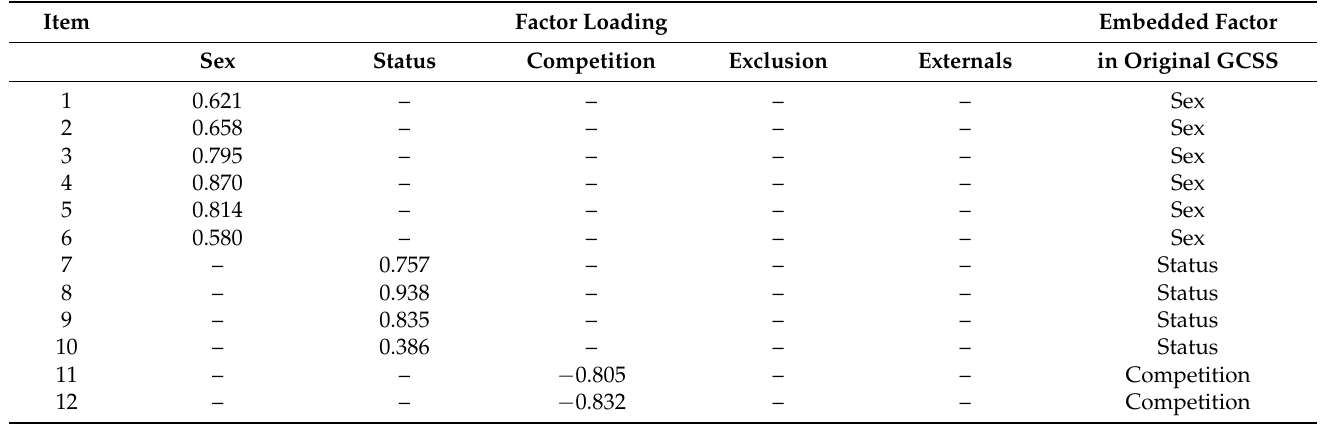
Table 3. Results of factor loadings derived from exploratory factor analysis for the Gay Community Stress Scale